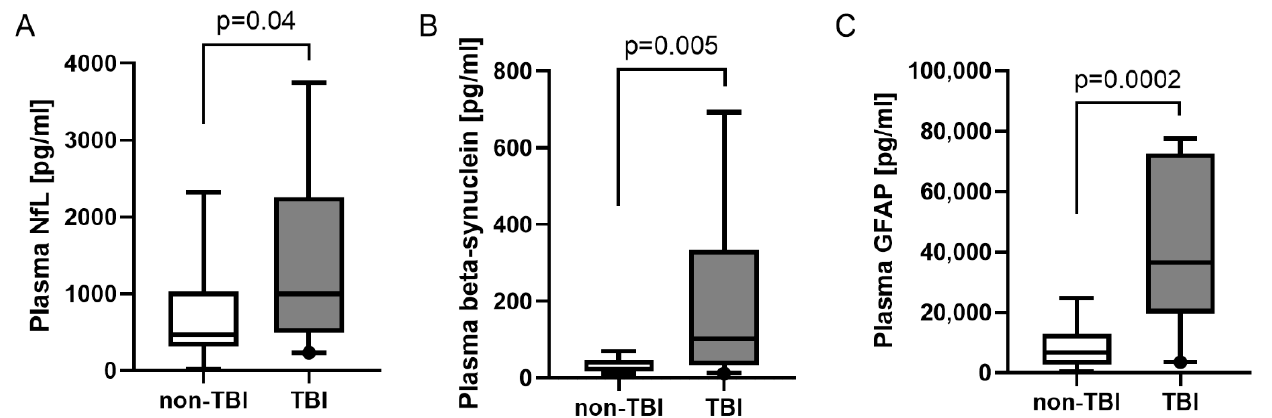
Figure 3. Differences and discrimination between severe trauma patients with and without TBI. ( A – C ) Difference in maximum observed plasma concentrations of NfL ( A ), beta-synuclein ( B ), and GFAP ( C ) between severely injured trauma patients with and without TBI. Concentrations are displayed as box plots. The median concentration, the 25% and 75% percentiles, and whiskers from 5% to 95% are illustrated. Groups were compared by Mann–Whitney U test. N = 19 (with TBI), and n = 13 (without TBI). GFAP, glial fibrillary acidic protein; NfL, neurofilament light chain; TBI, traumatic brain injury.